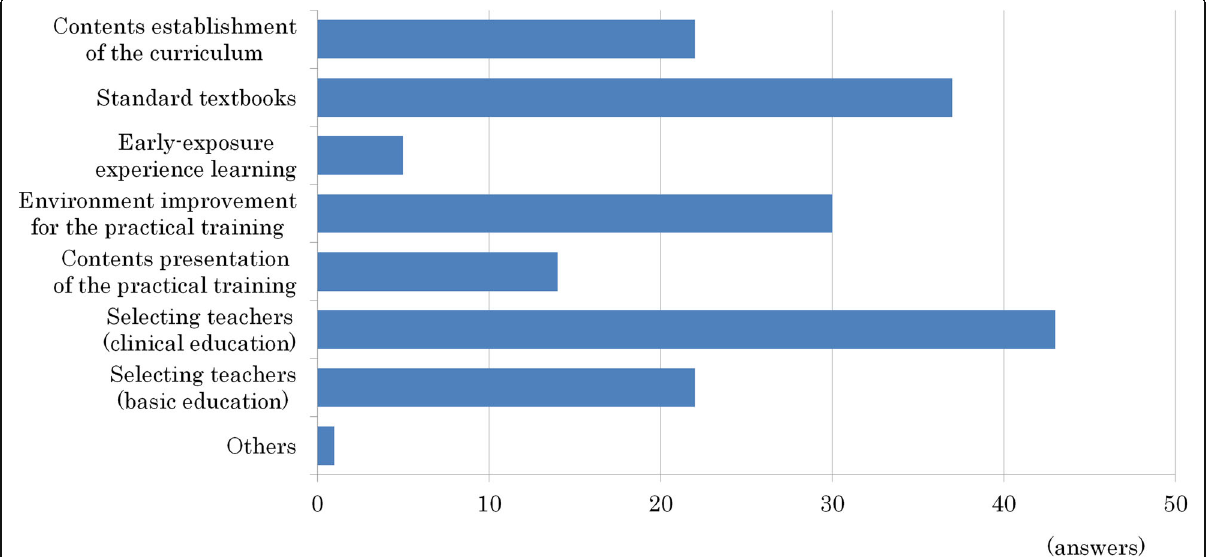
Fig. 6 The problems that have to be solved in the Kampo education from 74 schools. Selecting and retaining teachers who can teach Kampo medicine for clinical settings was the most critical problem (43 schools, 58%), followed by preparation of standard textbooks (37 schools,